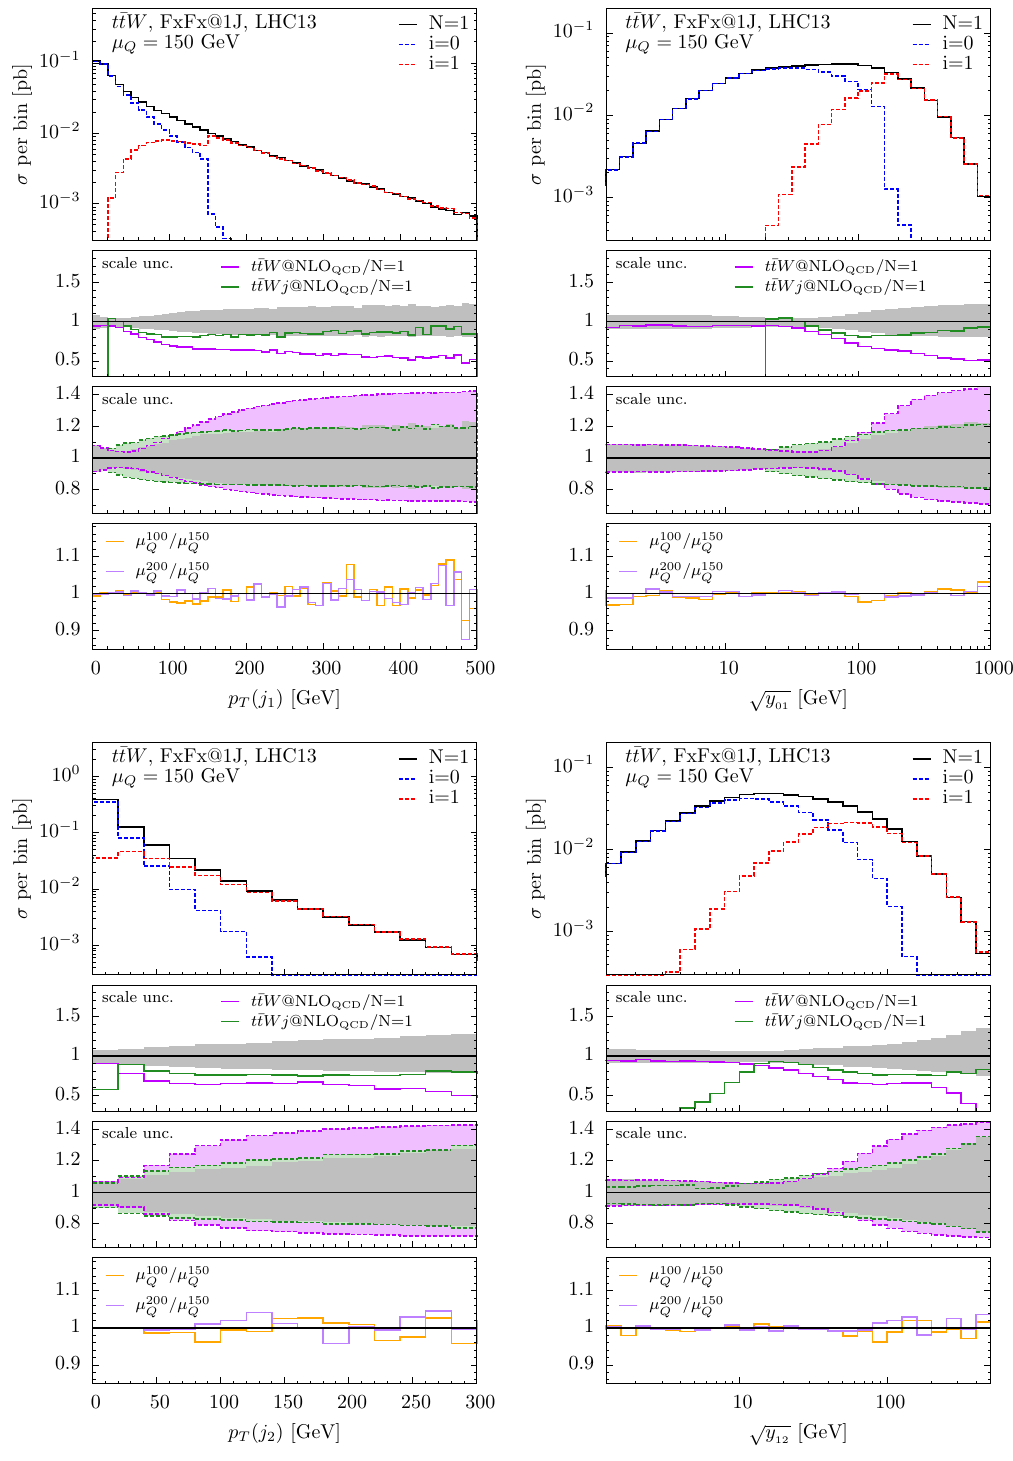
Figure 3 . Transverse-momentum differential distribution of the leading jet (left plot) and jet resolution y 01 distribution (right plot) for the t ¯ tW FxFx merged sample using µ Q = 150 GeV as merging